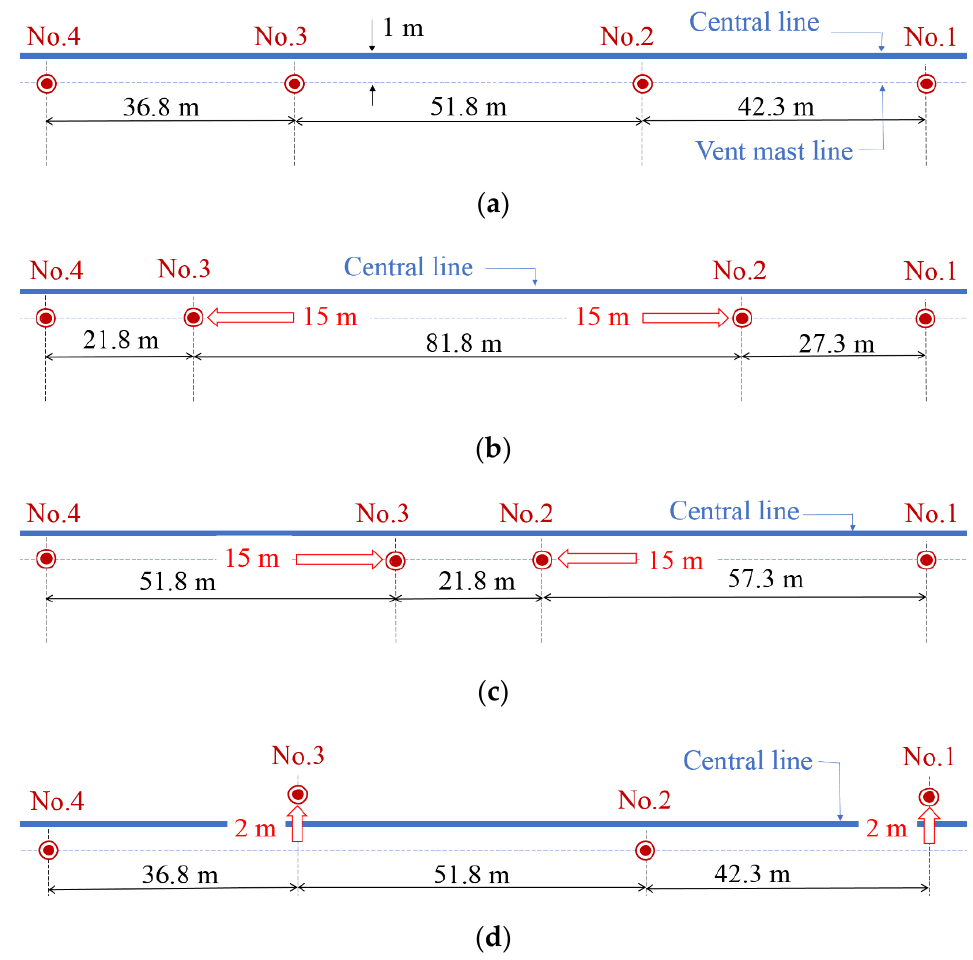
Figure 3. Four kinds of arrangements of the vent masts: ( a ) Reference ( b ) 1 ‒ 23 ‒ 4, ( c ) 12 ‒‒ 34, and ( d )